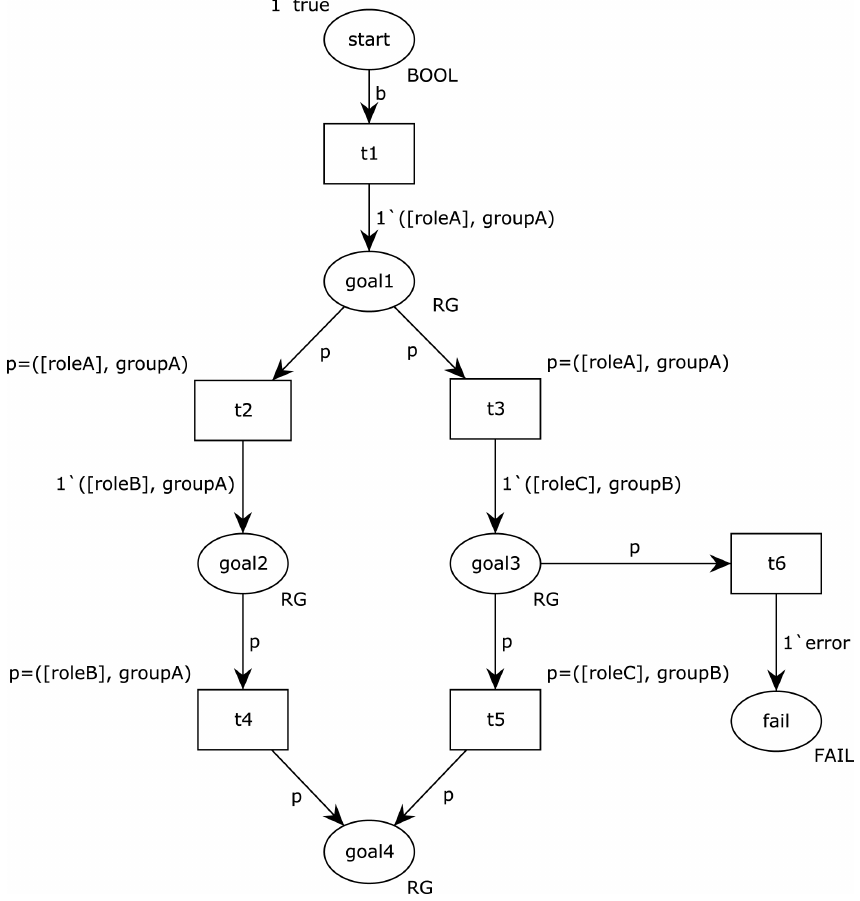
Figure 8. Example of a CPN with